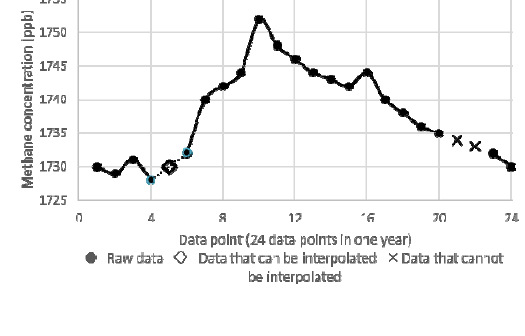
Figure 1. Time-series interpolation